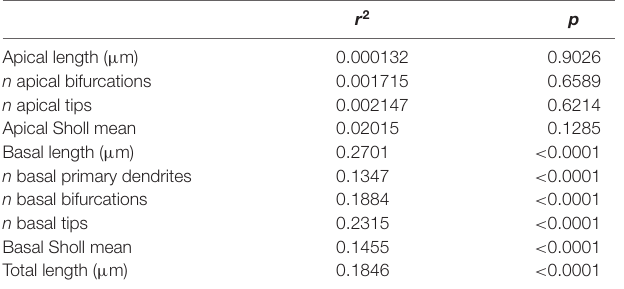
TABLE 2 | Ordering neurons by distance to principal axis origin reveals significant relationships between neuronal position and basal dendritic morphological properties.